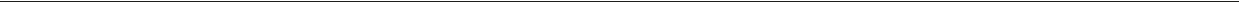
Fig. 2 TCRs are in transit between three different states of conformations. a Cartoon of the Resting, Active and Inhibited states. Blue and red arrows suggest a possible movement of the αβ ectodomains. Adoption of the three states is also re fl ected by movements of the cytoplasmic tails of the CD3 subunits. One of these movements results in exposure of the APA1/1 epitope in CD3 ε . b A mathematical model with just two states (Resting and Active) cannot explain the optimum time point for the Active conformation shown in Fig. 1d, e. Rather, Active conformation reaches a plateau of inde fi nite duration. c Summary of reactions included in the model. The letters R, A and I stand for the states Resting, Active and Inhibited. A nanocluster of three TCRs and a trimeric pMHC ligand were chosen for modelling. The numerical values of the parameters and an explanatory description of the states are summarised in Methods. The plus symbols stand for either empty or non-crosslinked bound ligand used for conciseness. d Model to explain how ligation of two or more TCRs by pMHC results in stabilisation of the Active conformation in the entire TCR nanocluster. Adoption of the Active conformation by unbound TCRs facilitates their binding to additional pMHC ligands. e Numerical integration of the 3-state model after addition of ligand. The right panel shows the existence of an optimum of the Active conformation (red circles), even though binding has not yet reached saturation. This behaviour re fl ects the experimental results in Fig. 1d – e. f Prediction of the existence of cooperative effects on pMHC ligand binding derived from the mathematical model. Preincubation of TCR nanoclusters with free ligand at different times displays an optimum cooperation at the time when the maximal number of